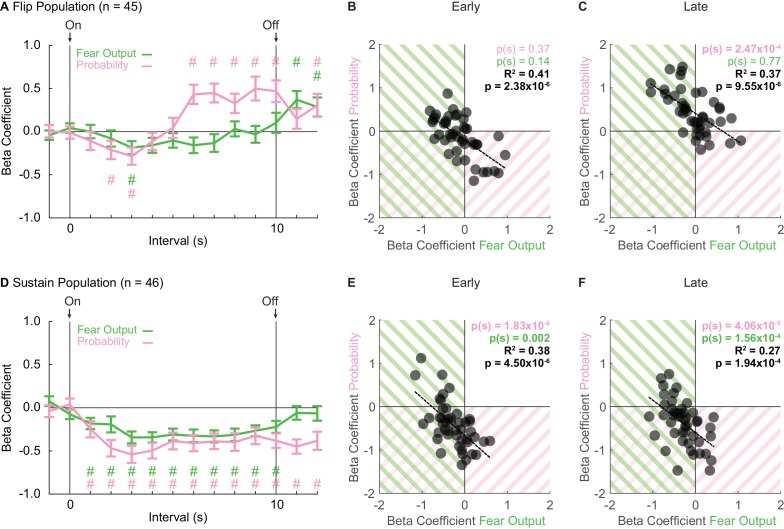
Sustain and Flip populations signal threat probability and fear output.(A) Mean ± SEM beta coefficients are shown for each regressor (probability: pink, fear output: green), in 1 s intervals, for the Flip population (n = 46). (B) Beta coefficients during the first, 5 s of cue presentation (Early) for fear output and threat probability are plotted for all Flip neurons. Black dashed trendline, the square of Pearson’s correlation coefficient (R2) with associated p value, and sign test p value demonstrating regressor bias shown. Background shading indicates negative beta coefficients, color coded by regressor. (C) Beta coefficients during the last, 5 s of cue presentation (Late) for fear output and threat probability are plotted for all Flip neurons. (D) Mean ± SEM beta coefficients are shown for each regressor for the Sustain population (n = 46). All graph properties maintained from A. (E) Beta coefficients during Early cue presentation for fear output and threat probability are plotted for all Sustain neurons. All graph properties maintained from B. (F) Beta coefficients during Late cue presentation for fear output and threat probability are plotted for all Sustain neurons. #95% bootstrap confidence interval for beta coefficient does not contain zero.